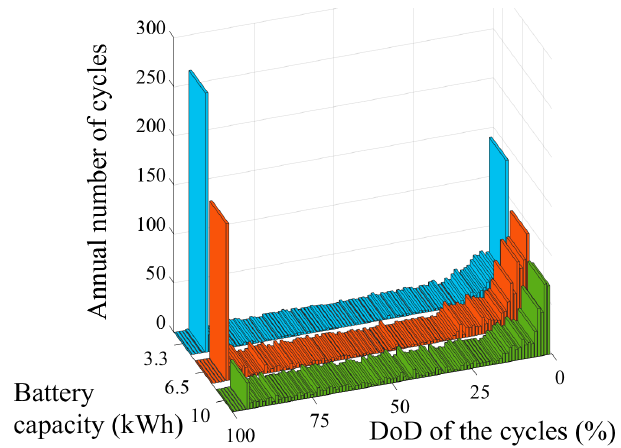
Figure 6. Histogram for the number of cycles for each depth of discharge (DoD) for three different battery capacities.